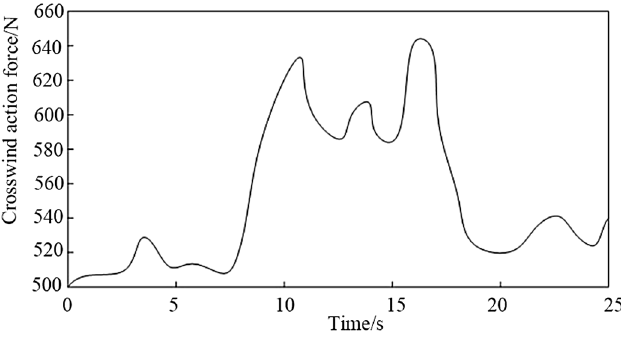
Fig. 4. Crosswind action force.